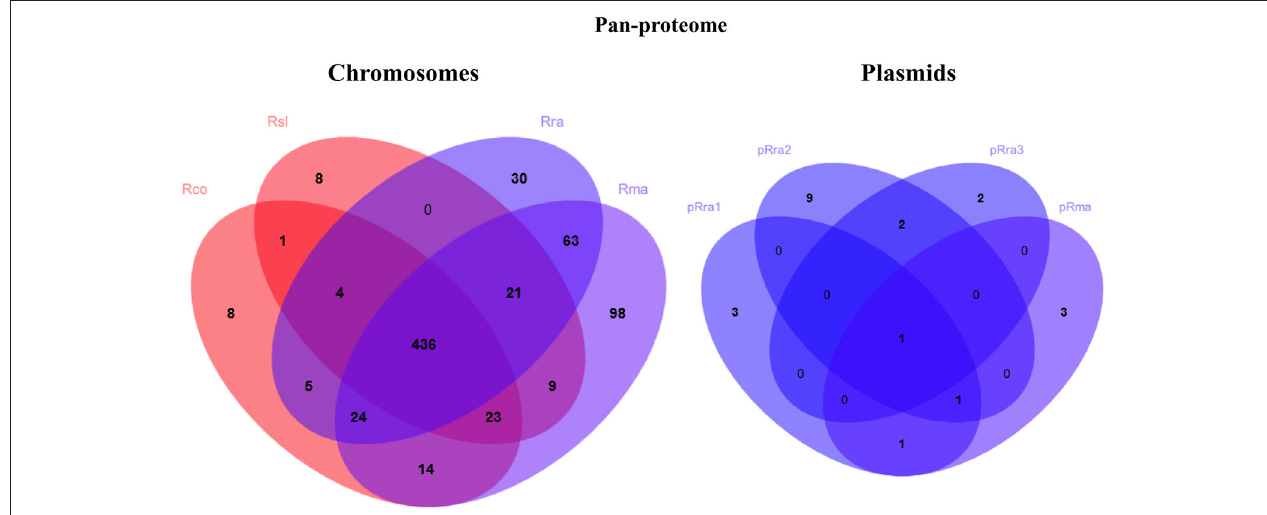
FIGURE 4 | Venn diagrams summarizing pan-proteome of the virulent R. slovaca Rsl and the milder R. raoultii Rra causing SENLAT, and the virulent R. conorii Rco and the milder R. massiliae Rma causing MSF.